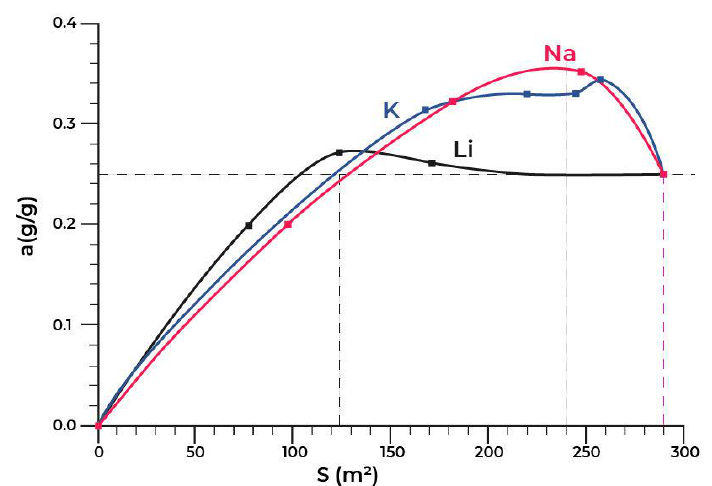
Figure 6. Dependence of the adsorption capacity of the modified materials (a) on the specific surface (S sp ).